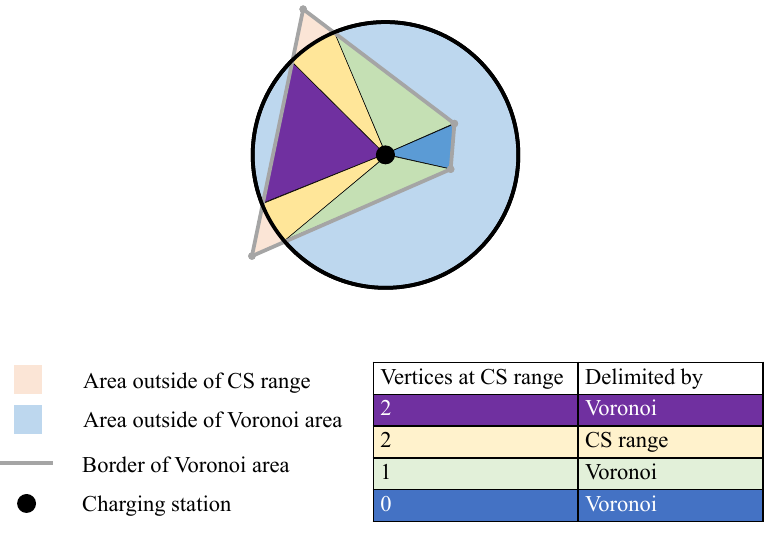
Figure 4. Example of the area a CS covers. The attractiveness of all points in the gray area is integrated to form the attractiveness of the